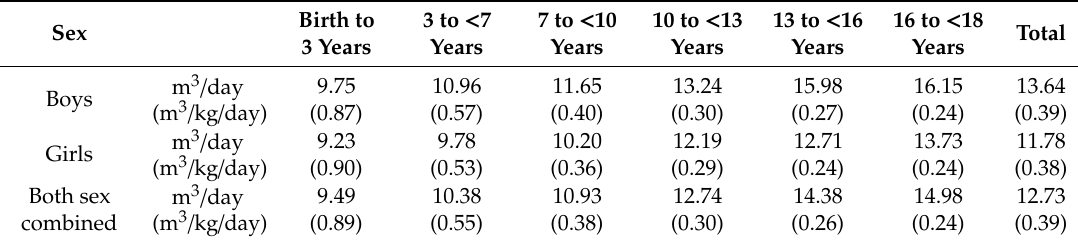
Table 4. Recommended values for inhalation rate according to age group.